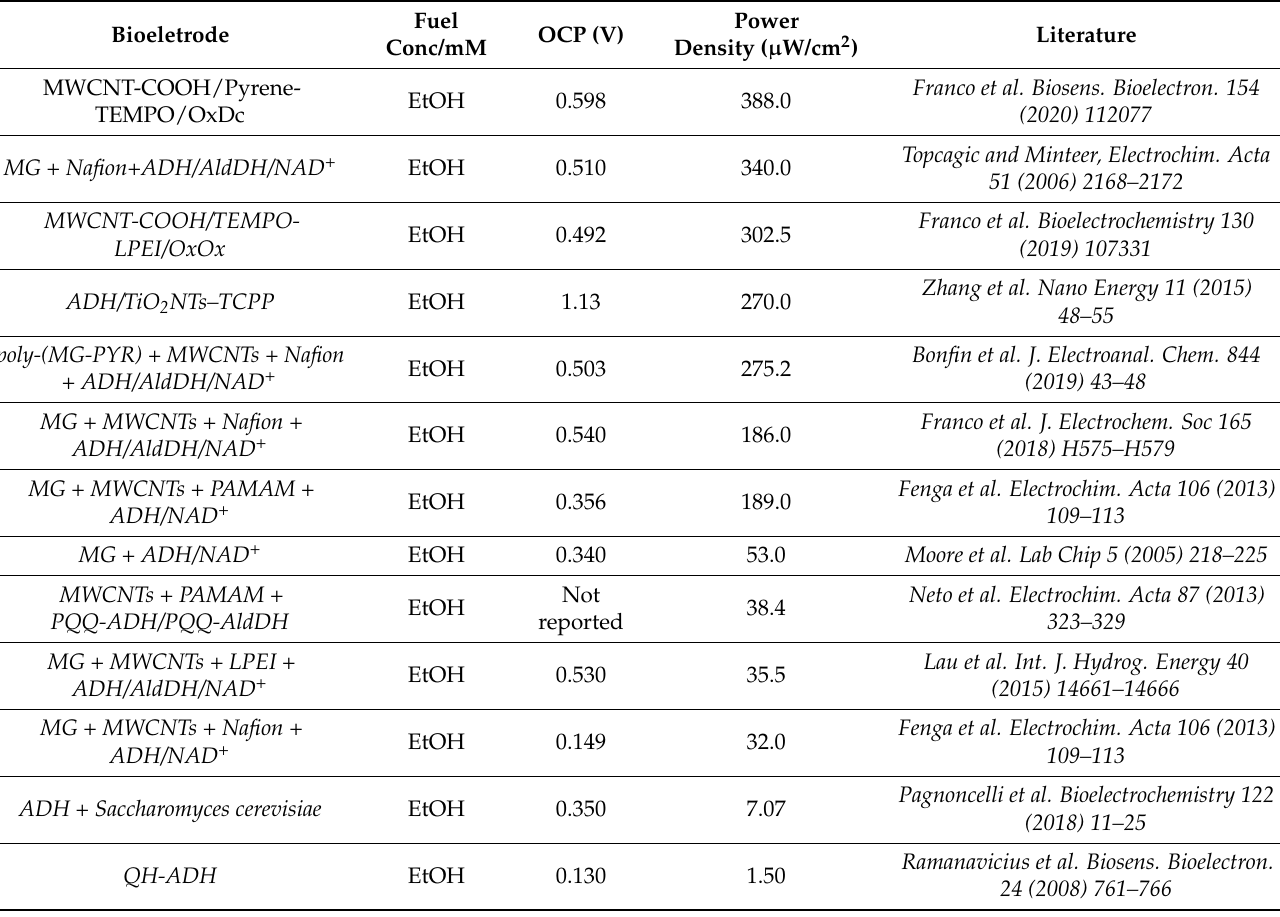
Table 1. Power density generated for different ethanol self-powered biosensors (ESPB) ethanol biofuel cell architectures.